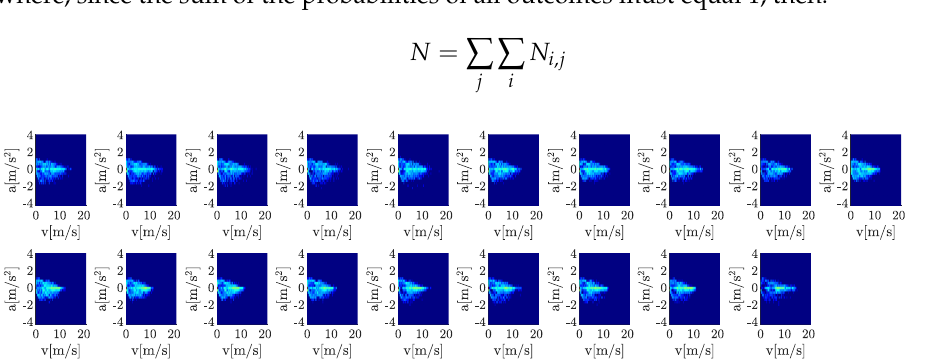
Figure 5. Representation of the vehicle speed–acceleration probability distribution (SAPD) for the 19 loops